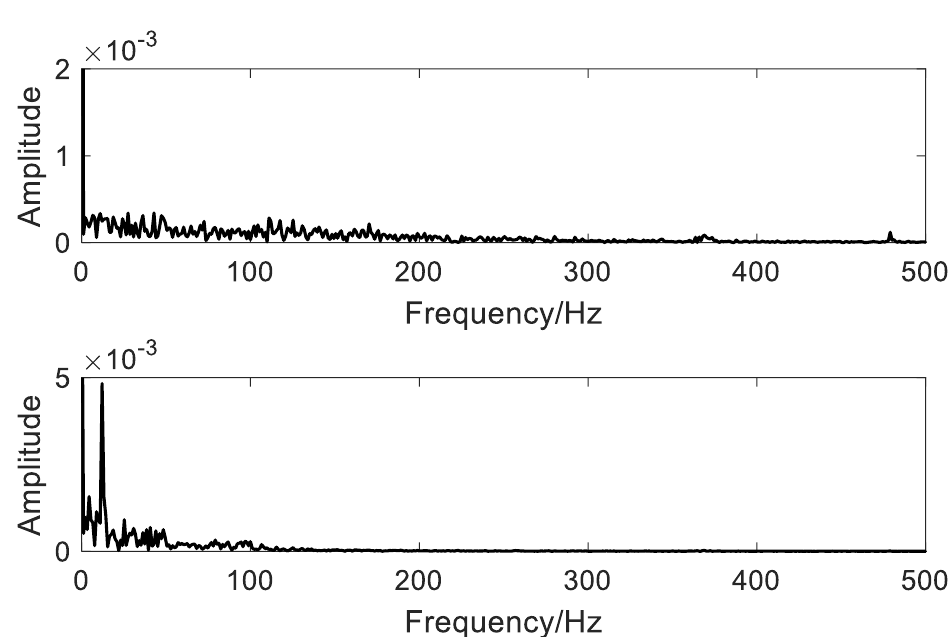
Figure 15. Spectra analysis of fifth component under F1 and F3.